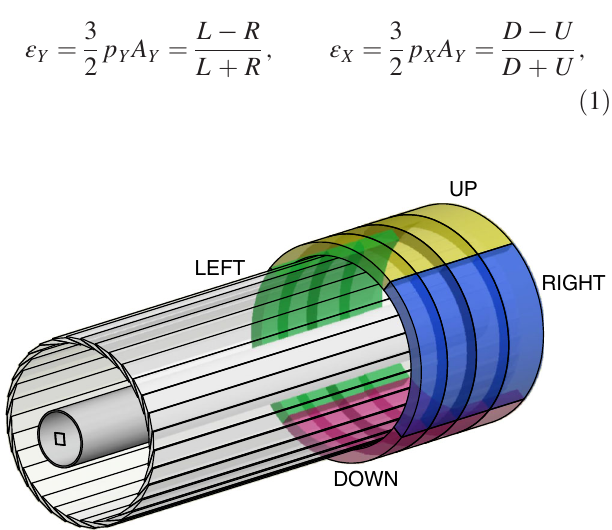
FIG. 1. Perspective drawing of the EDDA outer scintillator detectors used here as a polarimeter. The inside layer consists of 32 long bars arranged into a cylinder running parallel to the beam outside the beam pipe. The outside layer consists of a series of rings that wrap around the bars and each intercepts a narrow range of scattering angles from the target. The beam goes from left to right. Only the rings used in this experiment are shown; others surround the bars upstream. The bars are read out by photo- multiplier tubes located at the ends of the bars. The rings are split into left and right halves. Each half is connected to a light guide and single photomultiplier tube. A tube target, shown here as a small open square, is located at the front of the beam pipe. Readout organization into four quadrants, denoted by the colored ring segments, is discussed in the